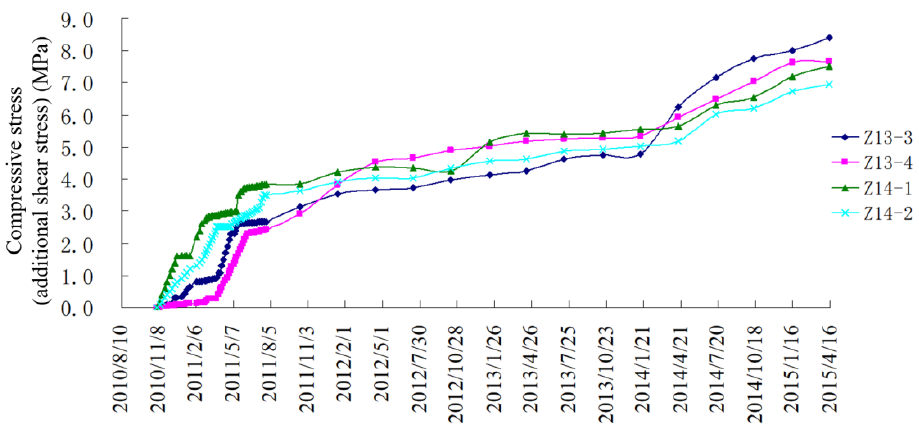
Figure 18. The stress–time curve of each measuring point of fault F3 monitored by the borehole stress meter.